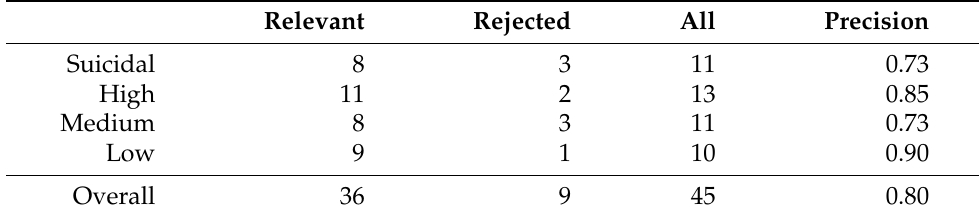
Table 56. Precision of relevant category pair correlation selection procedure. Relevant Rejected All